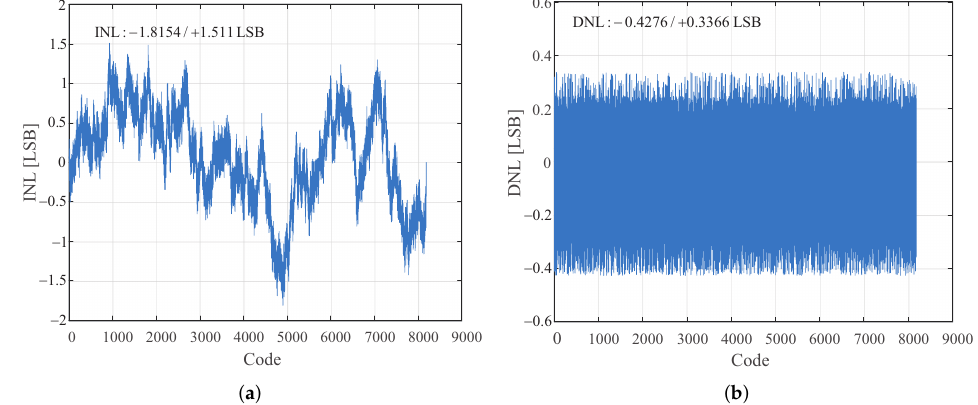
Figure 14. ( a ) Measured results of integral nonlinearity. ( b ) Measured results of differential nonlinearity.